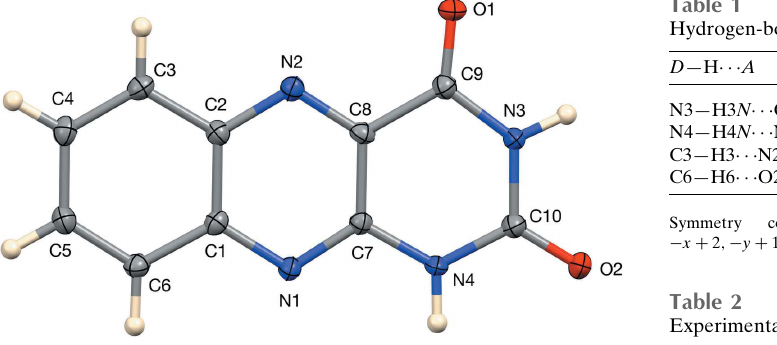
Figure 1 The title molecule with 50% ellipsoids.